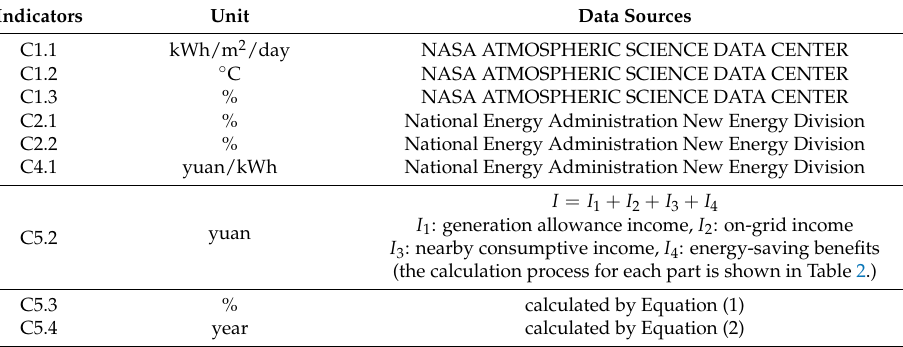
Table 3. Introduction to data